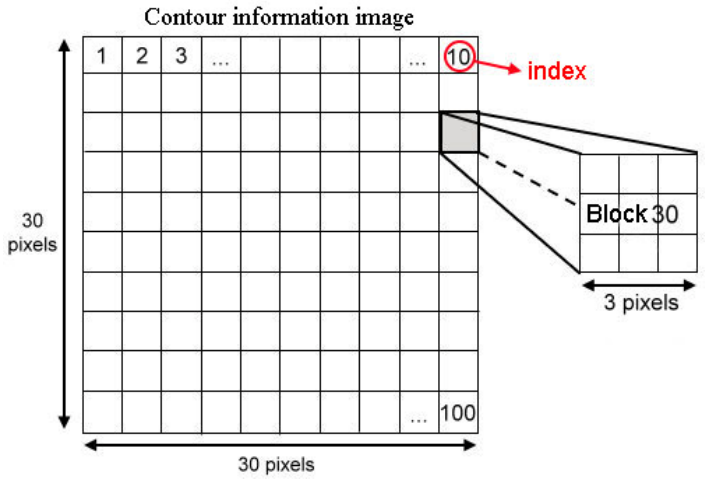
Figure 9. Reduction of dimensions of the feature